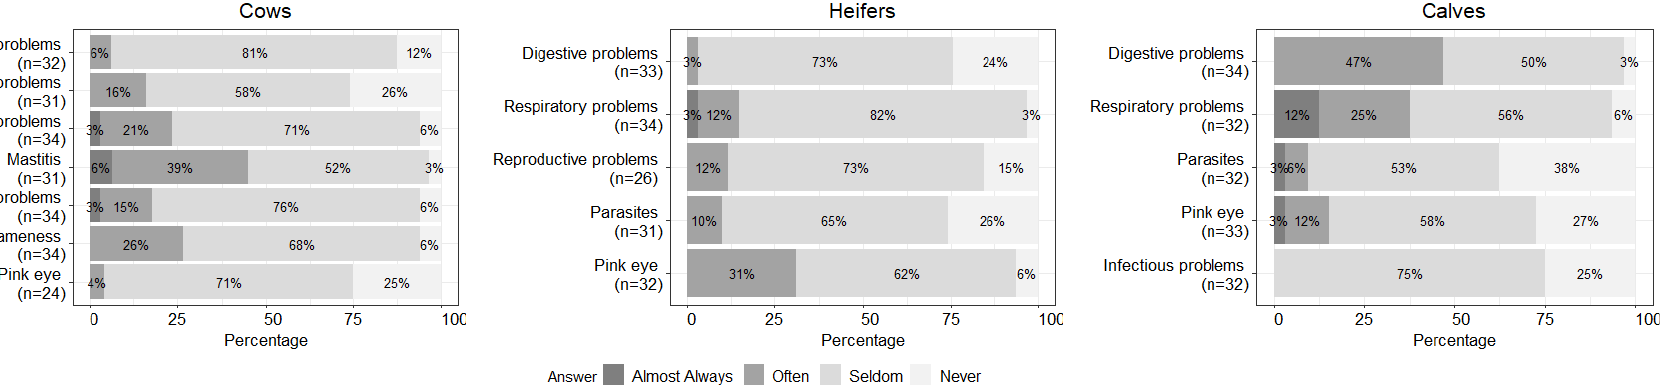
Figure 3. Frequency of diseases and disorders in each age class as reported by farmers (n = 36 farms surveyed).